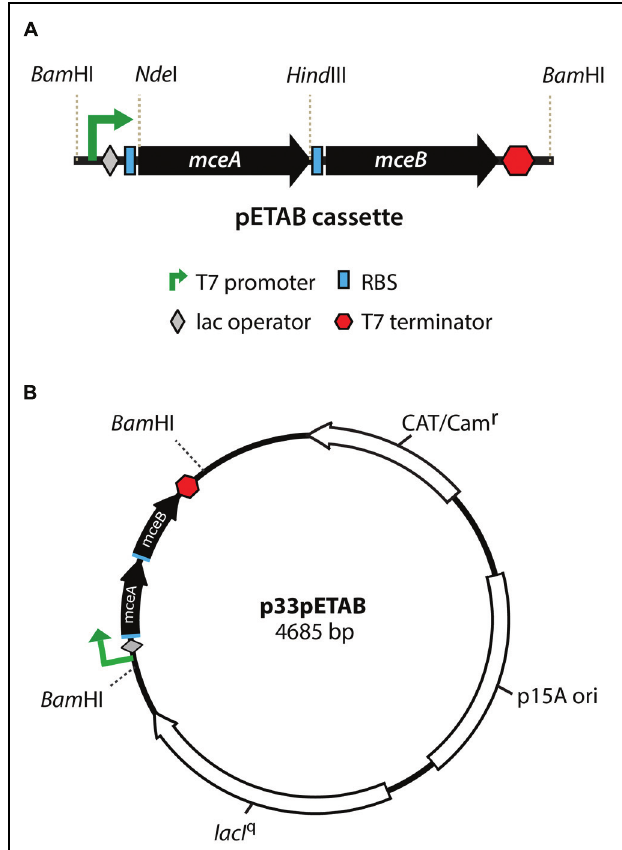
FIGURE 1 | Properties of the pETAB cassette for regulated expression of MccE492. Genes mceAB were cloned under a T7 promoter with further regulation by lac operator (A) . A consensus ribosome binding site (RBS) was included upstream of each coding region. This cassette was introduced in the BamH I site of p33AM, generating p33pETAB (B) that expresses constitutively lacI q , to repress expression from the T7 promoter in the absence of IPTG. Different versions of the mceA genes can be replaced in this construction using the Nde I /Hind III restriction